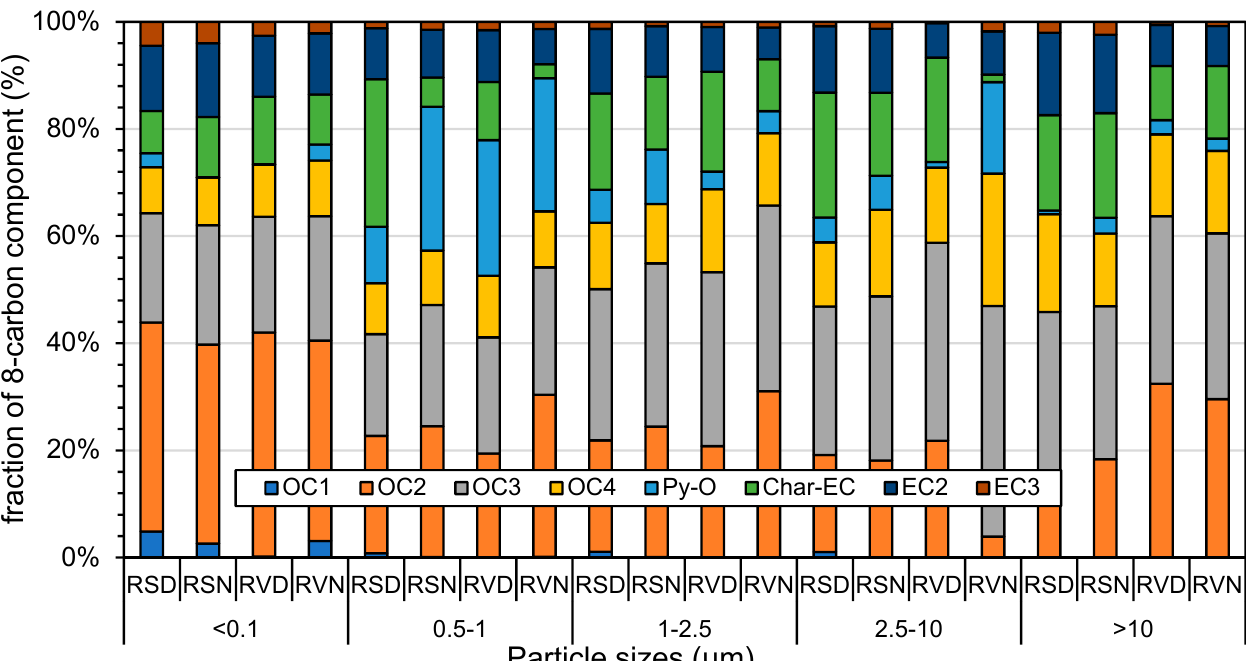
Figure 5. Fraction 8 carbonaceous component for both RS and RV at diurnal and nocturnal.